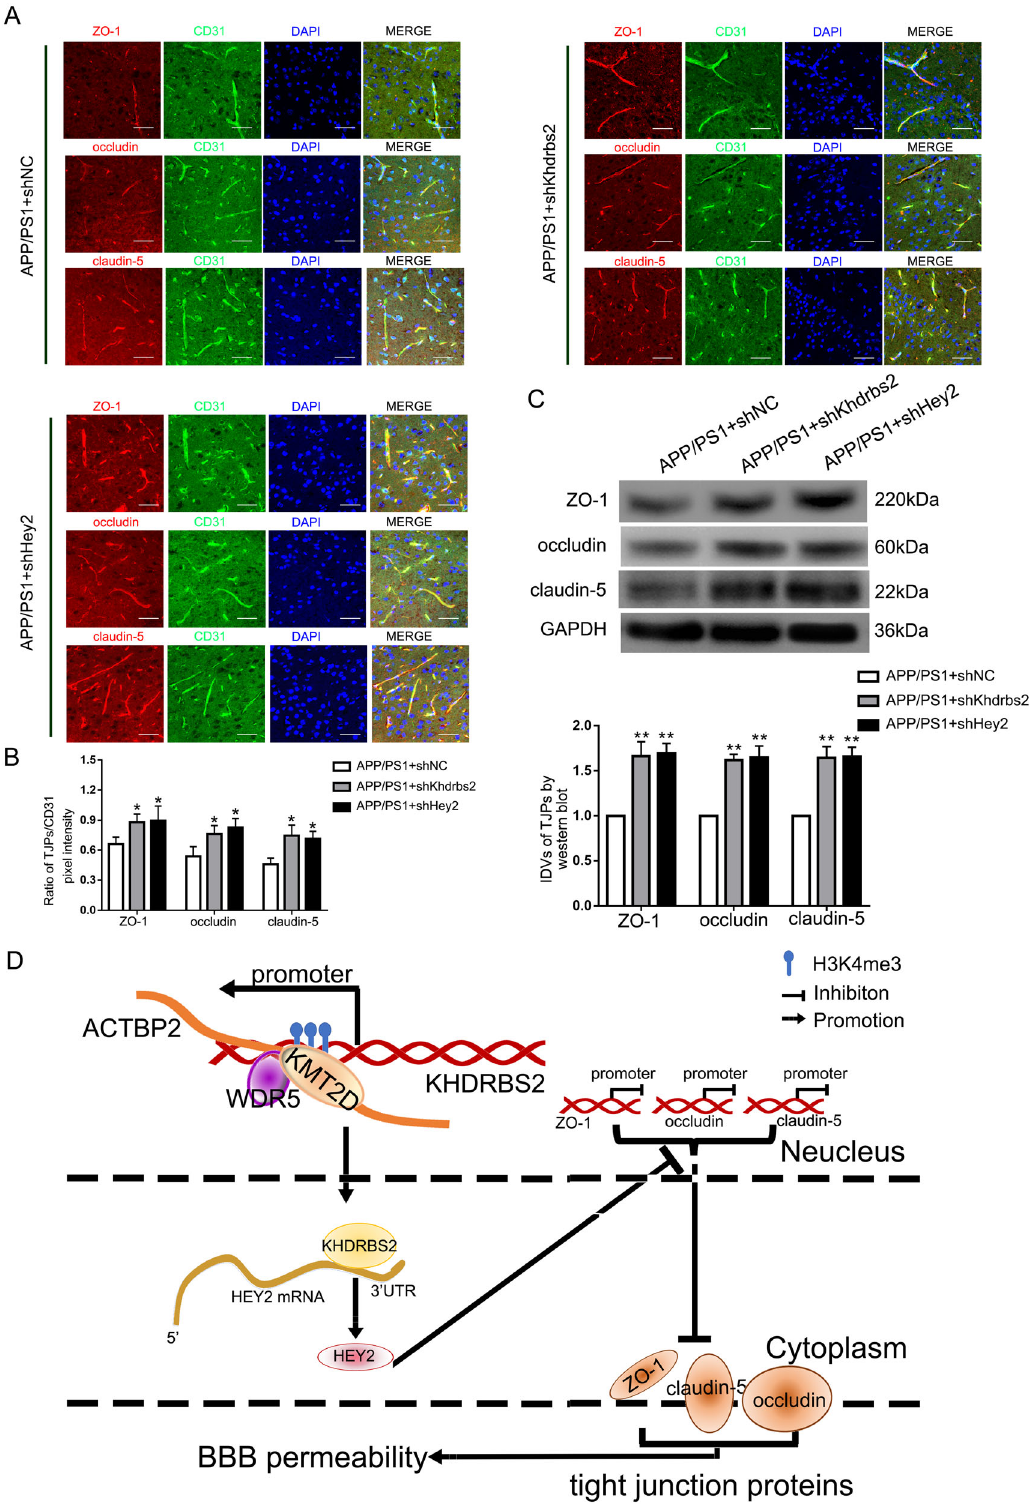
Fig. 7 Increase of ZO-1, occludin, and claudin-5 expression caused by Khdrbs2 knockdown or Hey2 knockdown in APP/PS1 mice brain microvessels. A Immunohisto fl uorescence staining of ZO-1, occludin, and claudin-5 expression in vivo. Frozen slices (10 μ m thick) of the corpus striatums from APP/PS1 + shNC, APP/PS1 + shKhdrbs2, and APP/PS1 + shHey2 groups were stained with CD31 (green), TJPs (red), and DAPI (blue). Scale bar represents 100 μ m. B Quanti fi cation of pixel intensity. ( n = 5) C The effects of Khdrbs2 knockdown or Hey2 knockdown on APP/PS1 brain microvessels. Data are presented as mean ± SD ( n = 3). * P < 0.05 versus APP/PS1 + shNC group, ** P < 0.01 versus APP/PS1 + shNC group. D The schematic illusion of interactions between ACTBP2, KHDRBS2, and HEY2 in A β 1 – 42-incubated